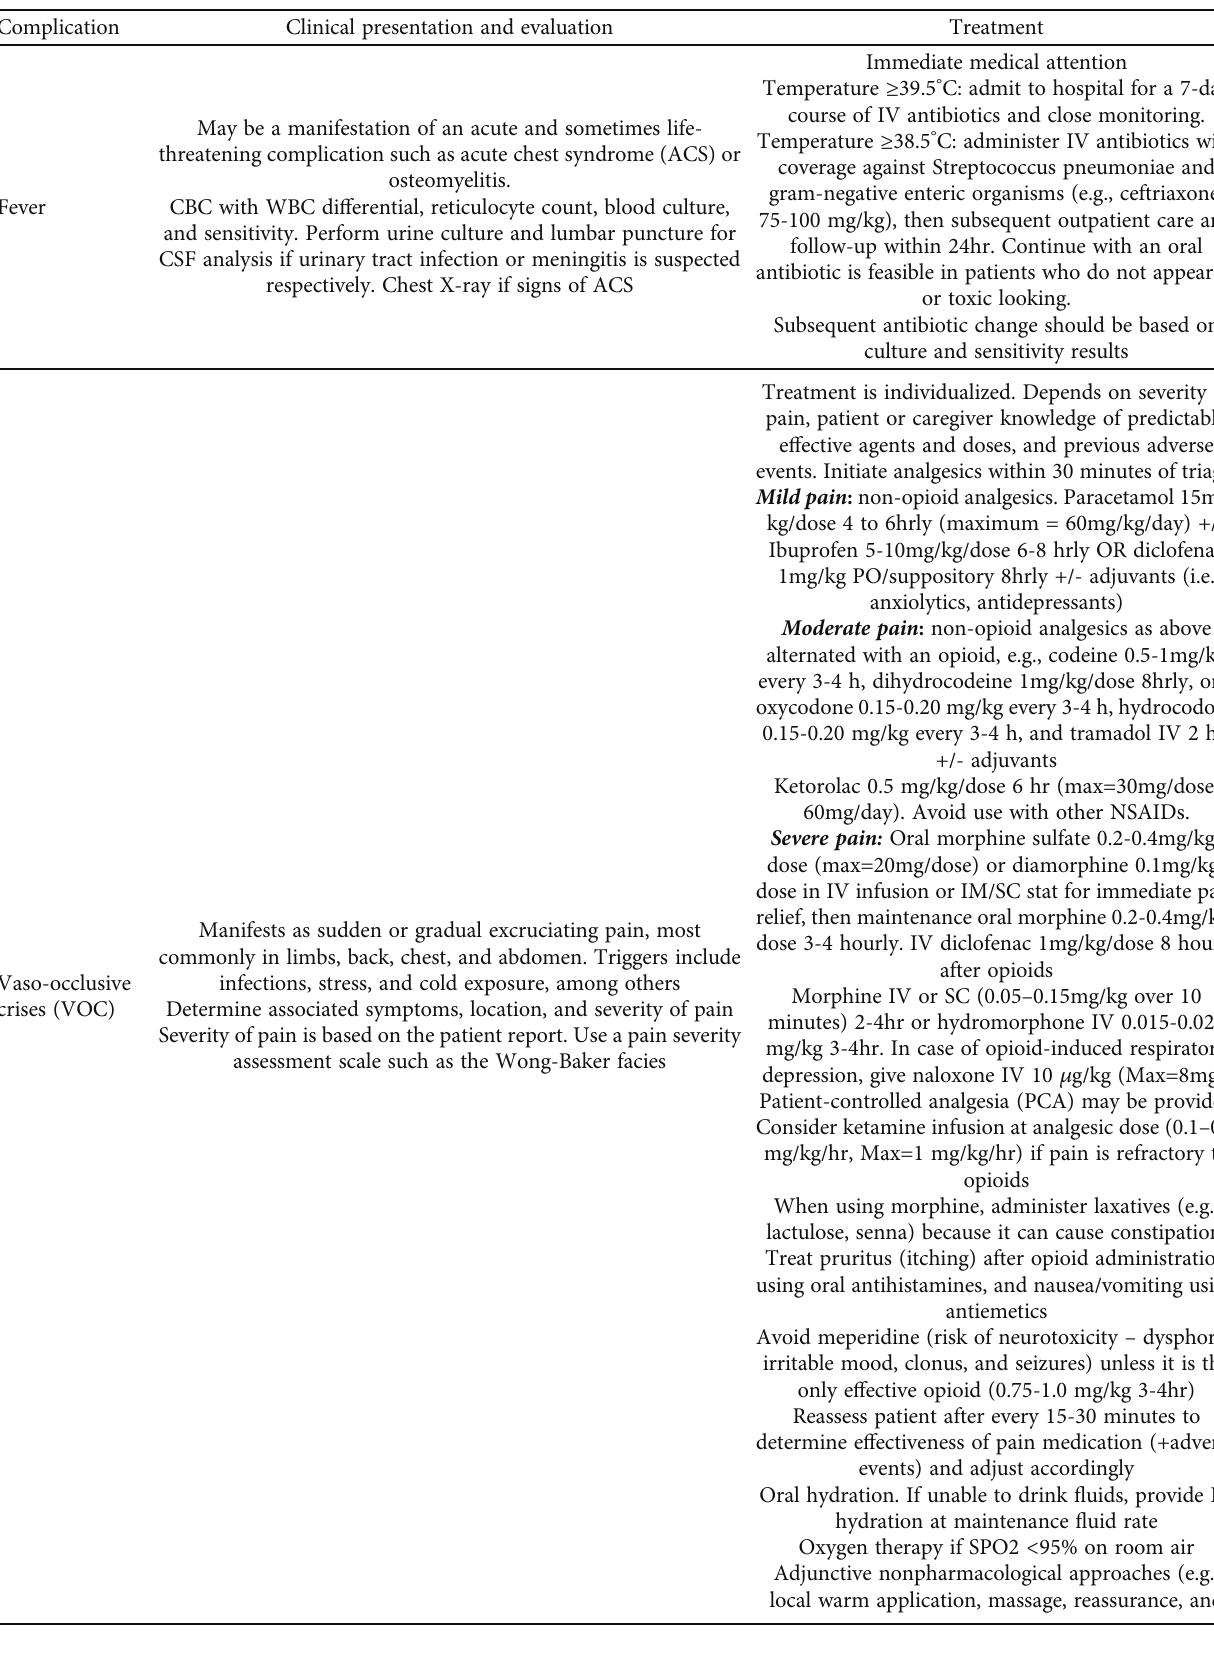
Table 4: Diagnosis and treatment of acute complications of